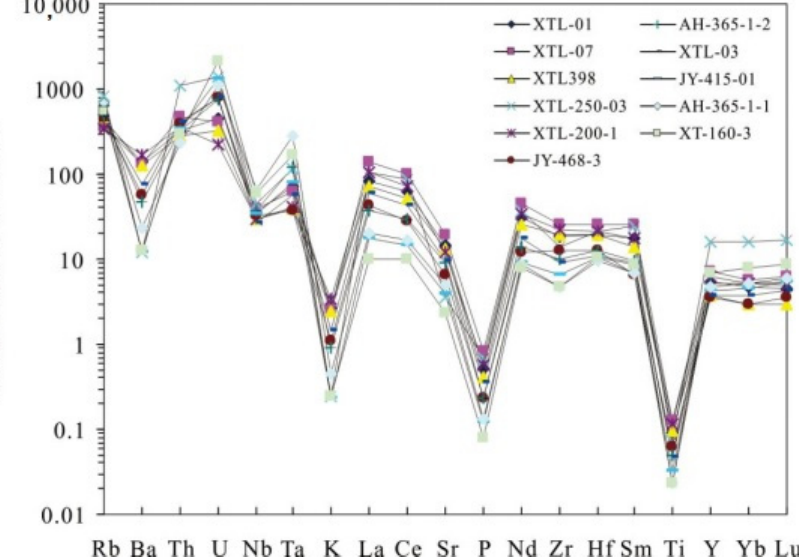
Figure 10. Primitive mantle-normalized spider diagram of trace elements for granites in Xintianling ore field, Hunan, China.